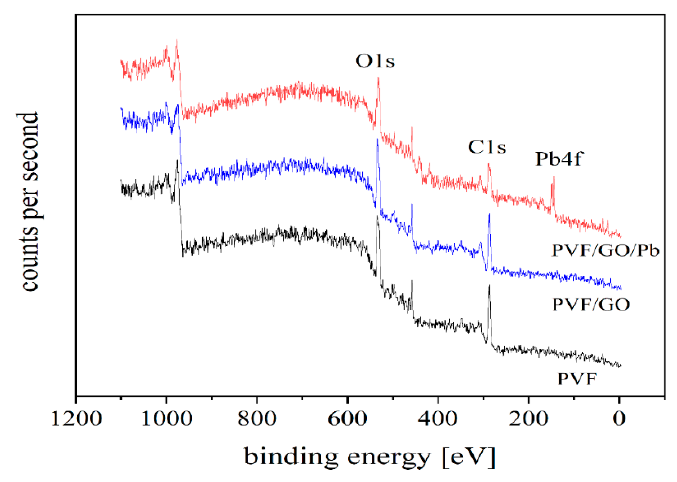
Table 1. Surface composition of PVF, PVF/GO, and PVF/GO/Pb, as determined by XPS.